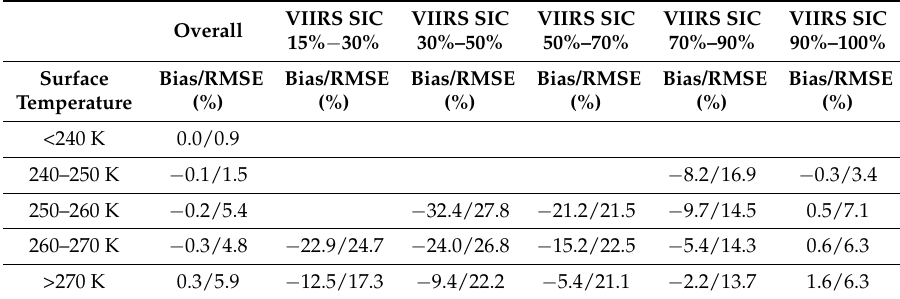
Table 6. Bias and RMSE with bias removed (precision) for comparison of VIIRS minus Landsat ice concentrations for different concentration ranges/bins for different surface temperature ranges with match-up pairs more than 1000.